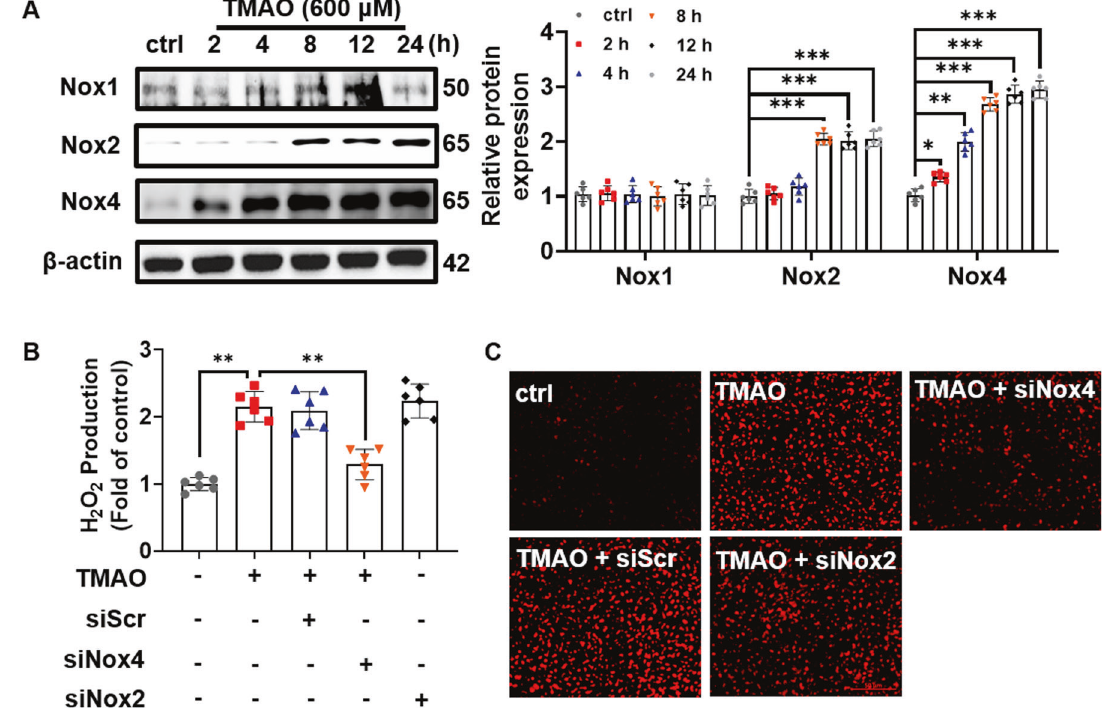
Fig. 5 NOX4 knockdown decreases H 2 O 2 production in VSMC treated with TMAO. A Representative blots and quantitative data of Nox1, Nox2 and Nox4 protein expression in TMAO (600 μ M) treated VSMC at indicated periods. The protein expression level was normalized